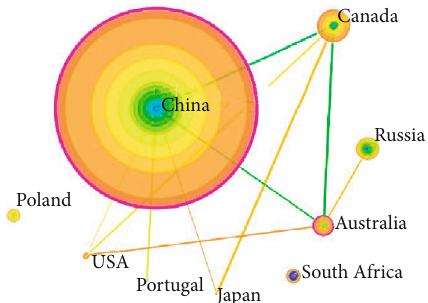
Figure 4: Country cooperation